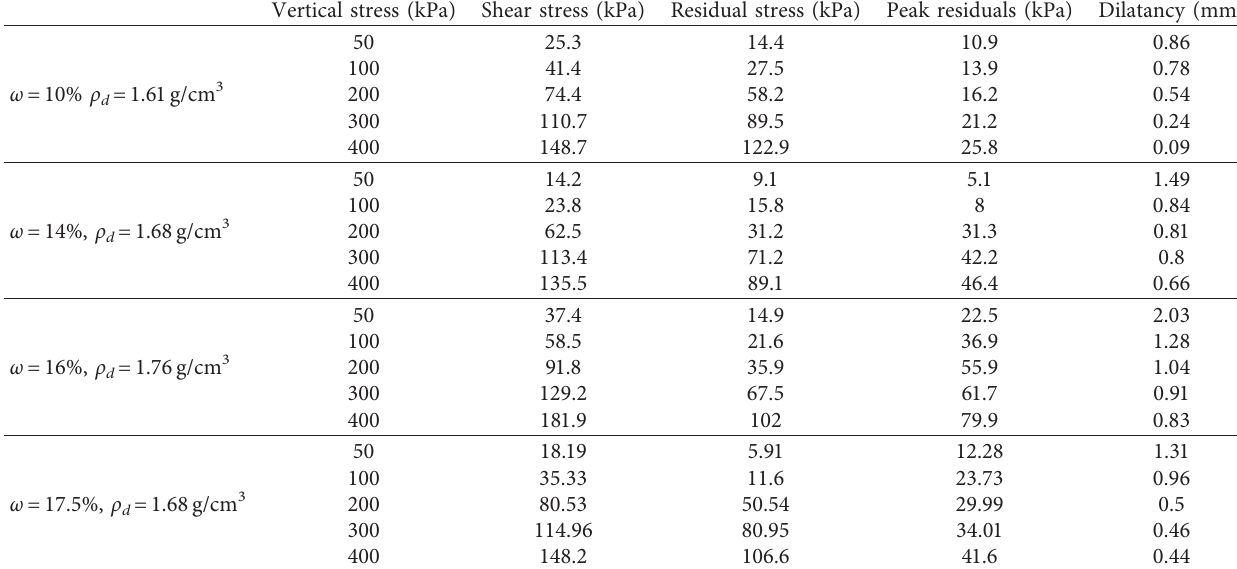
Table 3: Test results summary.